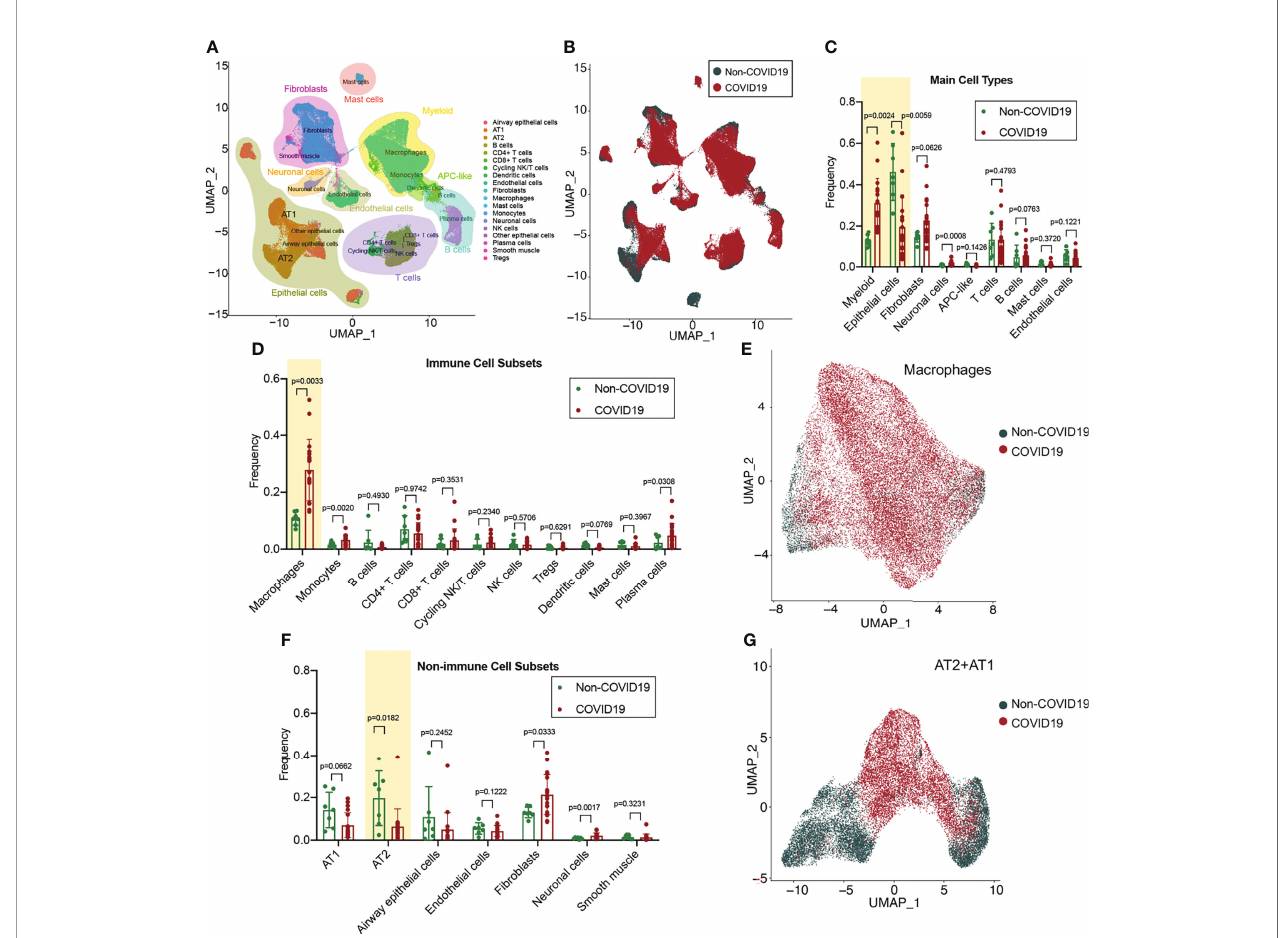
FIGURE 1 | Single-cell atlas and cell subset fractions in the lung tissue from COVID-19 patients. (A) Main clusters and respective cell-type assignments in the uniform manifold approximation and projection (UMAP). (B) Origins of cells with same embedding in COVID-19 (n = 19) and non-COVID-19 (n = 7) lungs. (C) Fraction of main cell types in COVID-19 and non-COVID-19 lungs. (D) Fraction of immune cell subsets in COVID-19 and non-COVID-19 lungs. (E) UMAP and corresponding group assignments of the macrophages analyzed. (F) Fraction of non-immune cell subsets in COVID-19 and non-COVID-19 lungs. (G) UMAP and corresponding group assignments of the epithelial cells analyzed, including AT2 and